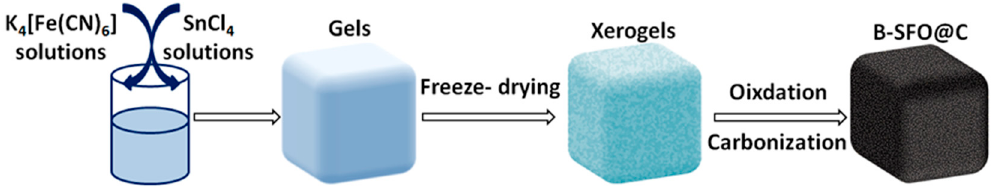
Figure 1. Schematic formation processes of B-SFO@C.